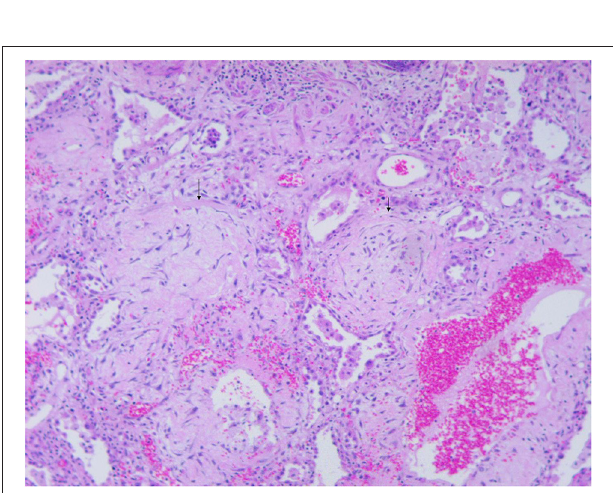
FIGURE 4 | Microscopic examination of the explanted lung (hematoxylin-eosin stain, × 50) shows extensive consolidation of lung tissue and pulmonary interstitial fibrosis (arrowheads). Ring fibrosis connecting alveolar orifice rings and inflammatory cell infiltration into the alveolar walls with pneumocyte hyperplasia and squamous